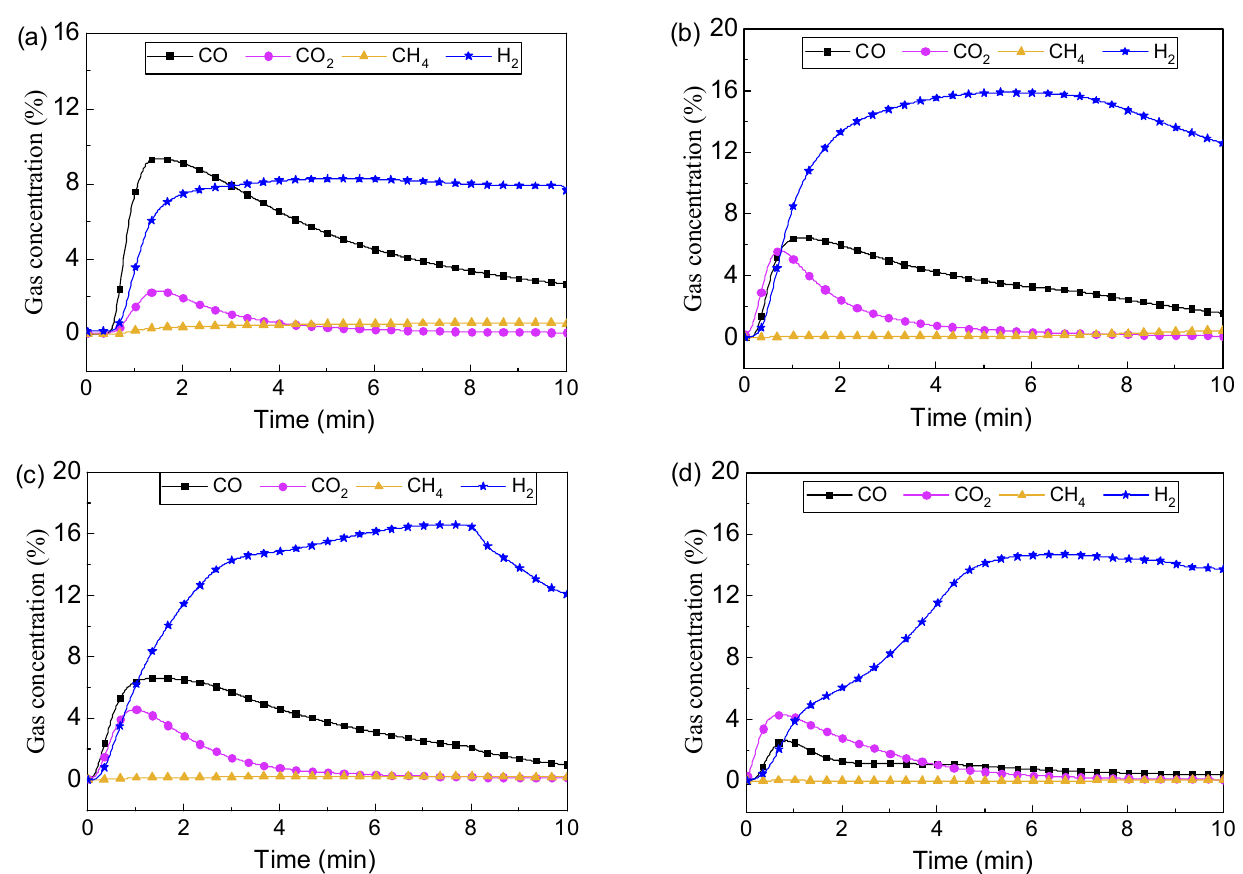
Figure 9. Gas evolution during chemical looping toluene conversion using LaFe 1-x Ni x at 900 ◦ C: ( a ) LaFe 0.8 Ni 0.2 ; ( b ) LaFe 0.6 Ni 0.4 , ( c ) LaFe 0.4 Ni 0.6 , ( d ) LaFe 0.2 Ni 0.8